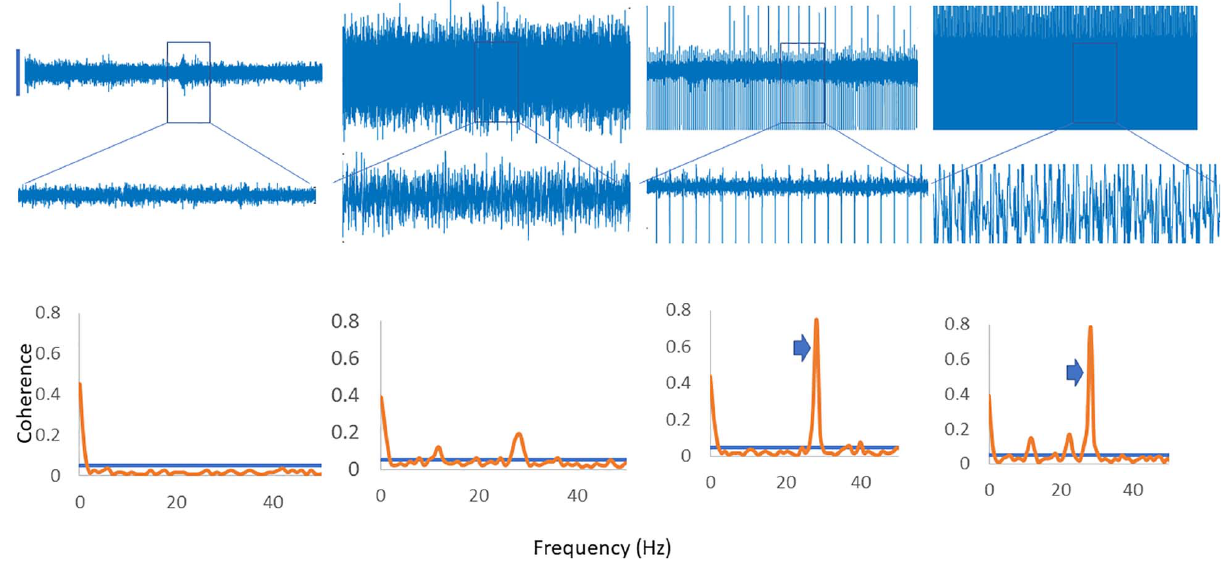
β -band except in the stimulation and contraction condition (right hand